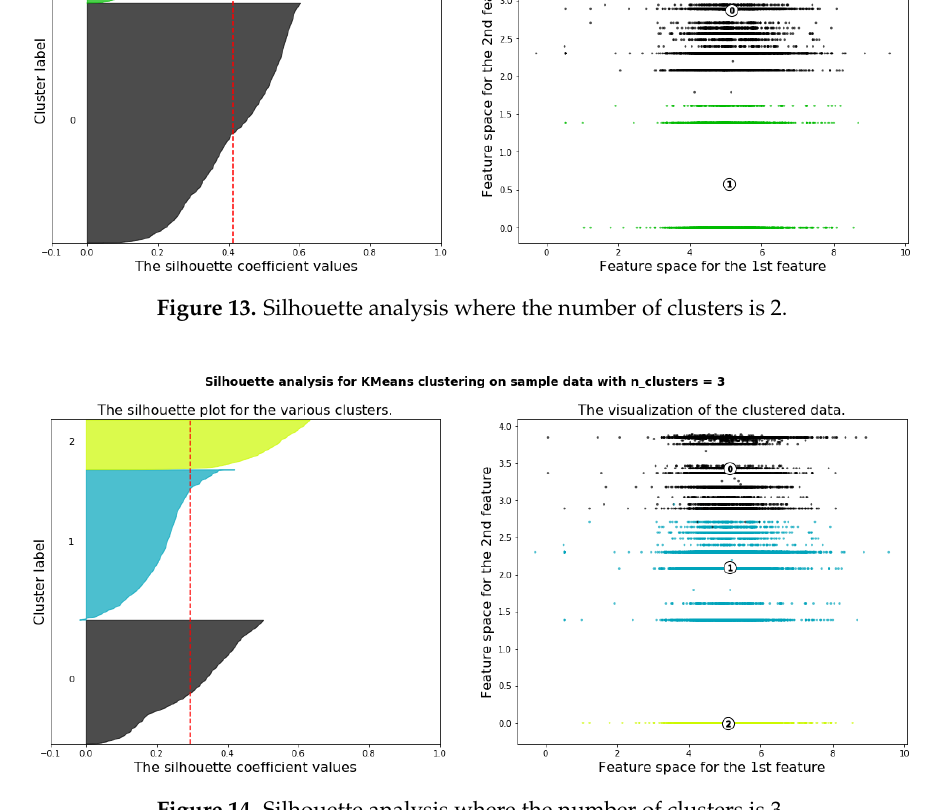
Figure 14. Silhouette analysis where the number of clusters is